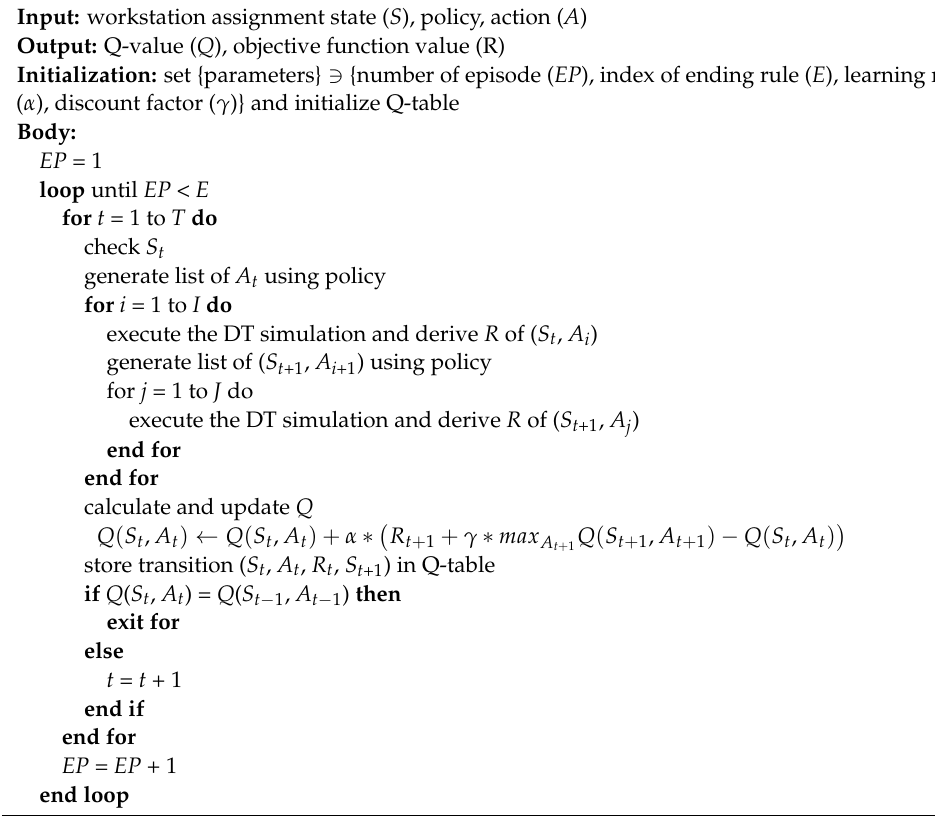
Algorithm 2: RL-based optimization algorithm DT-based Q-learning